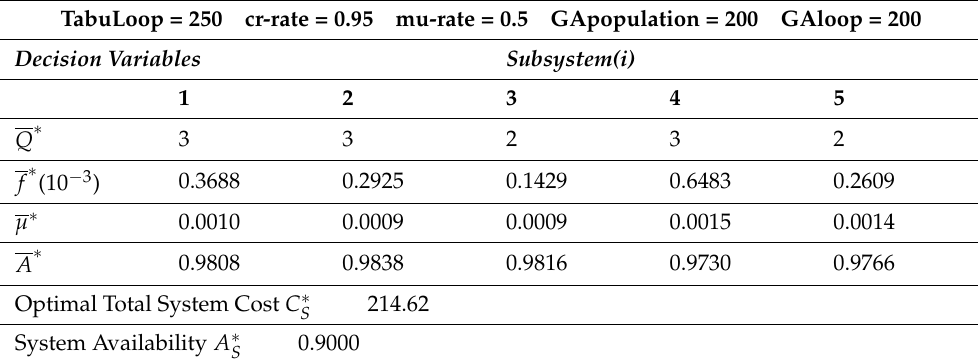
Table 18. Optimal Solutions obtained by TA–MGA for the parallel-series system.